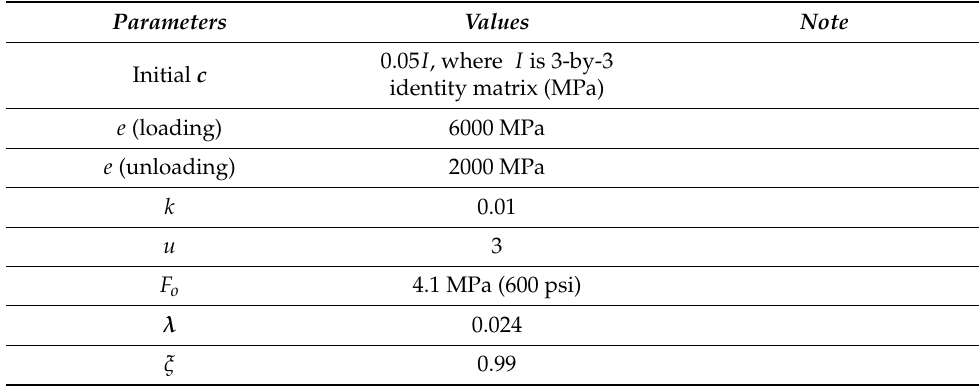
Table A4. Values of different parameters for sample 1 (test 1).